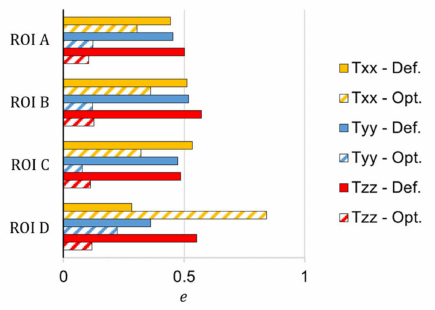
Figure 9. The discrepancy between the measured and predicted fiber